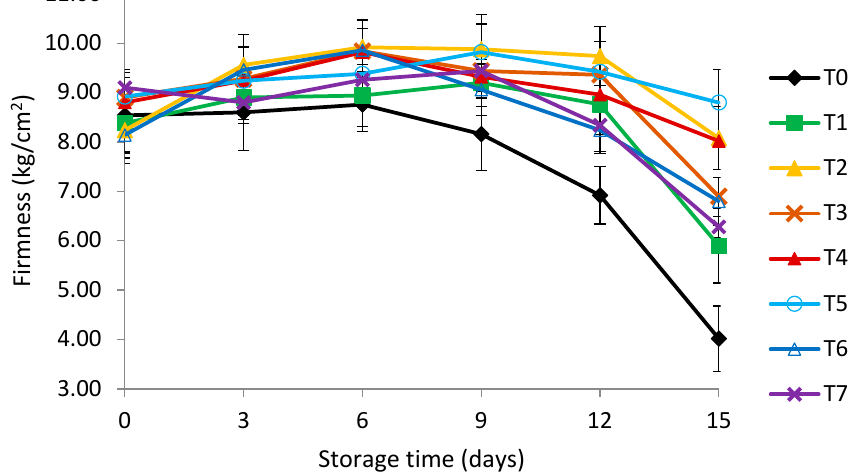
Figure 4. Firmness of control and treated fresh-cut pears stored for 15 days at 8 ± 1 °C. T0—Control; T1—0.2% PE + 1% CaCl 2 ; T2—0.2% PE + 1% CaCl 2 + 0.2% PS; T3—0.2% PE + 1% CaCl 2 + 0.2% PS + 1% N -AC; T4—0.2% PE + 1% CaCl 2 + 0.2% PS + 1% CA + 1% AA; T5—0.2% PE + 1% CaCl 2 + 0.2% SB; T6—0.2% PE + 1% CaCl 2 + 0.2% SB + 1% N -AC; T7—0.2% PE + 1% CaCl 2 + 0.2% SB + 1% CA + 1% AA. Values are the mean of 24 measurements (3 experiments × 8 replicates). Error bars represent ± SD.